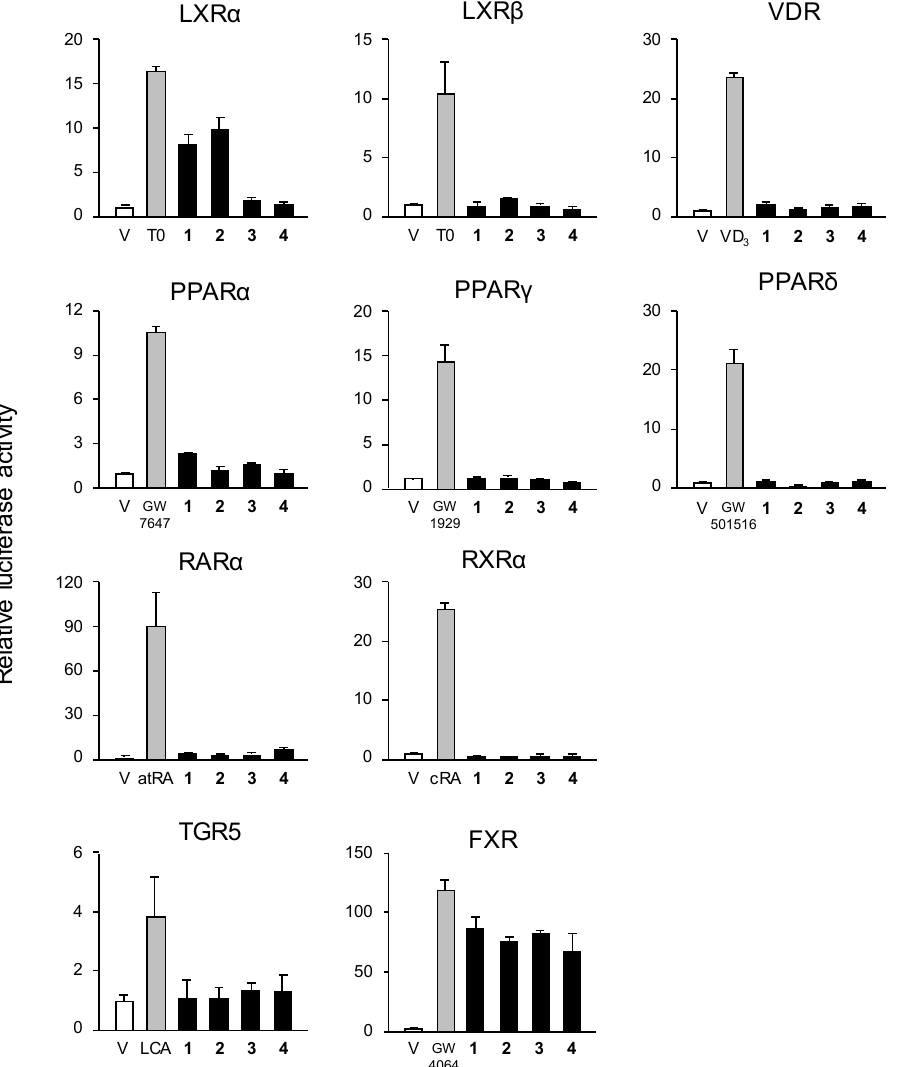
Figure 2. Specificity of FXR agonists to nuclear receptors. Huh-7, HEK293, or COS-7 cells (vehicle: V; white columns) were transfected with each of the plasmids for the nuclear receptor and the nuclear receptor-response element-driven luciferase gene. Then, the transfected cells were treated with each of the nuclear receptor agonists [LXR α / β : T0901317 (T0; 50 nM), VDR: 1 α ,25-vitamin D 3 (VD 3 ; 100 nM), PPAR α : GW7467 (50 nM), PPAR γ : GW1929 (50 nM), PPAR δ : GW501516 (50 nM), RAR α : all-trans-retinoic acid (atRA; 100 nM), RXR α : 9-cis-retinoic acid (cRA; 100 nM), TGR5: lithocholic acid (LCA; 200 nM), FXR: GW4064 (100 nM); gray columns] or novel FXR agonists 1 – 4 (1 µ M; black columns). Luciferase activity was measured, as described in Materials and Methods. Data are shown as means ± S.D. from three experiments in triplicate assay.